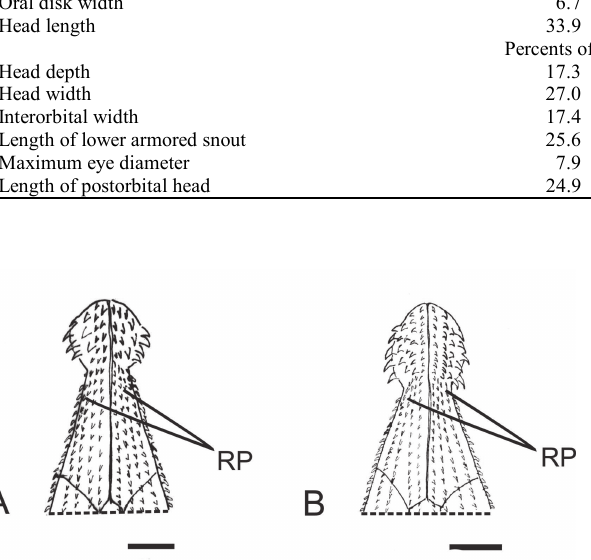
Fig. 3 . Pectoral spine. A. Acestridium triplax ; B. Acestridium dichromum . Scale: 1